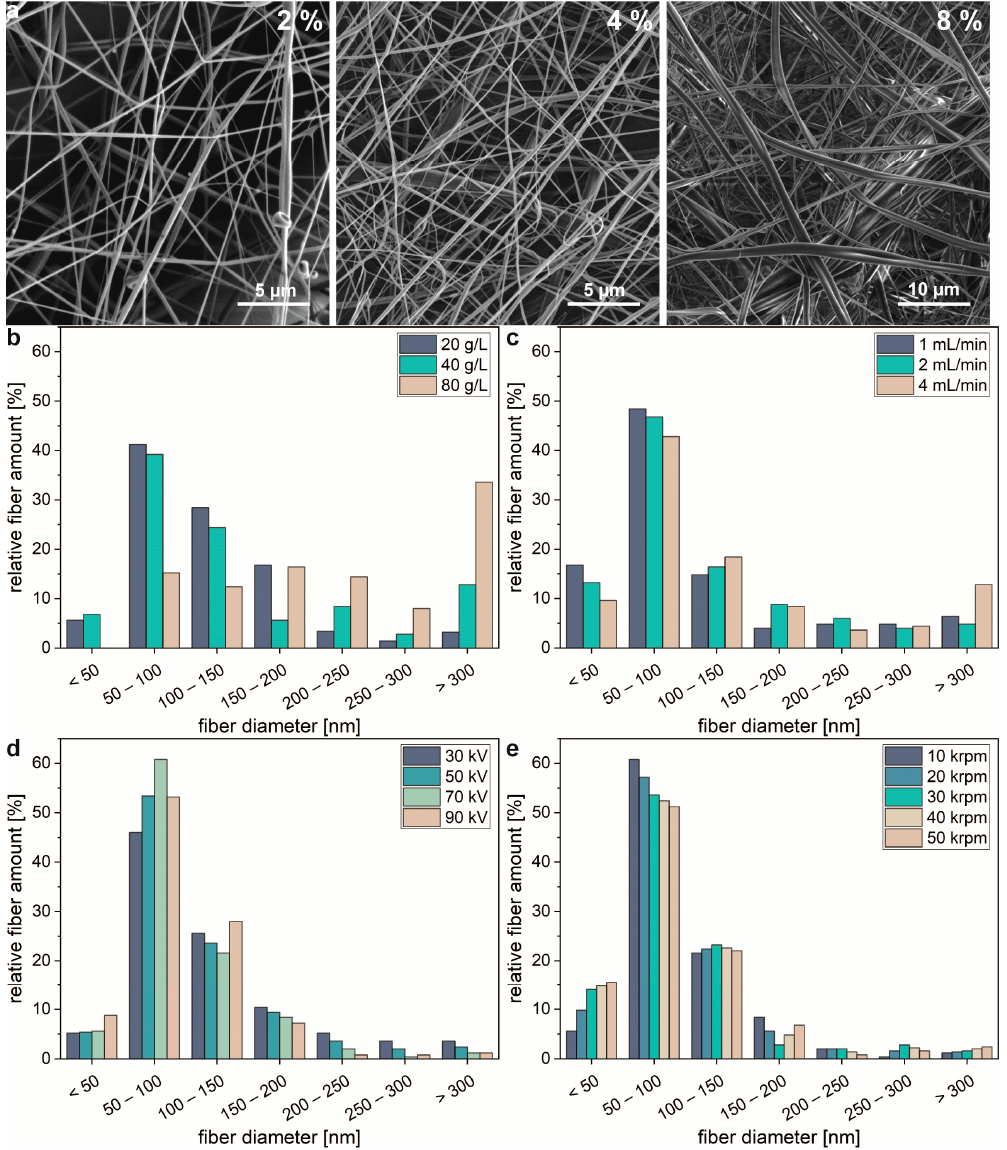
Figure 1. Nonwoven fiber diameter dependence on process parameters. ( a ) SEM images of centrifugal electrospun spider silk nonwoven meshes spun out of solutions at different concentrations given in % ( w/v ). ( b ) Fiber diameter distribution of spider silk nonwoven meshes made at different protein concentrations, ( c ) volumetric flow rates, ( d ) voltages, and ( e ) rotational speeds. For each experimental group, 250 independent samples ( n = 250) were tested. Further spinning parameters were ( a , b ) Q = 8 mL/min, U = 90 kV, and ω = 10 krpm; ( c ) c = 2% ( w/v ), U = 90 kV, and ω = 10 krpm; ( d ) c = 2% ( w/v ), Q = 2 mL/min, and ω = 10 krpm; ( e ) c = 2% ( w/v ), Q = 2 mL/min, and U = 70 kV. The potential of the collector was − 5 kV in all measurements.